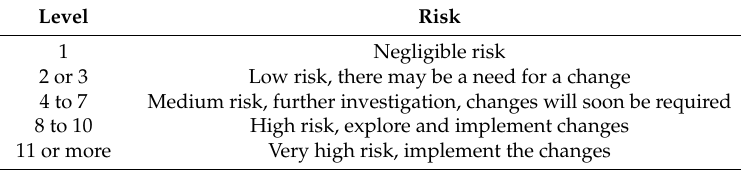
Table 2. Interpretation of results for the Rapid Entire Body Assessment (REBA) module.